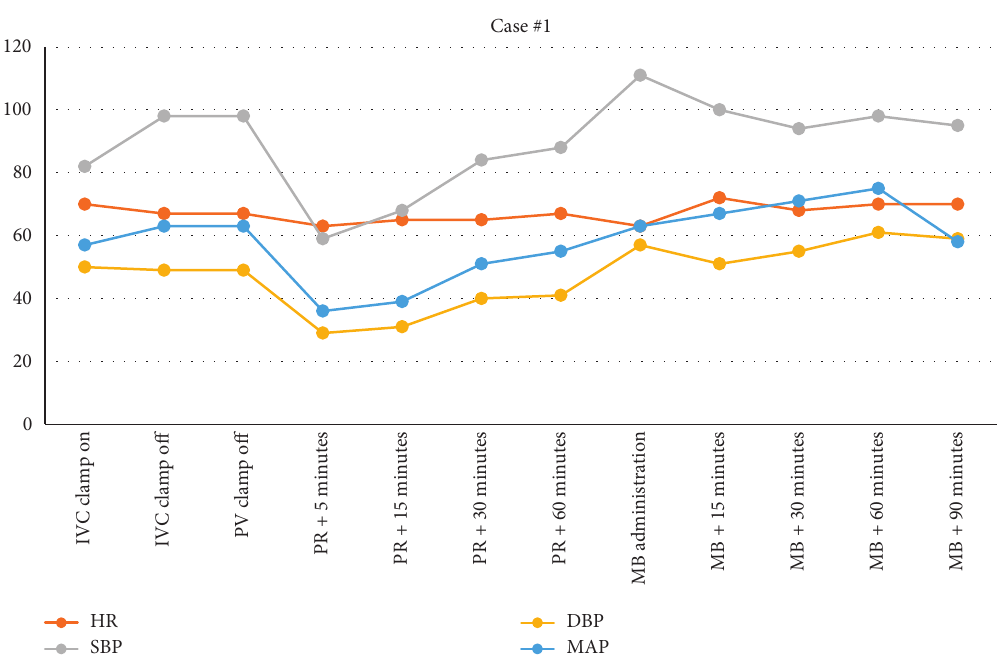
Figure 1: Vital signs from IVC clamp until 90 minutes following MB administration. IVC, inferior vena cava; PV, portal vein; PR, postreperfusion; MB, methylene